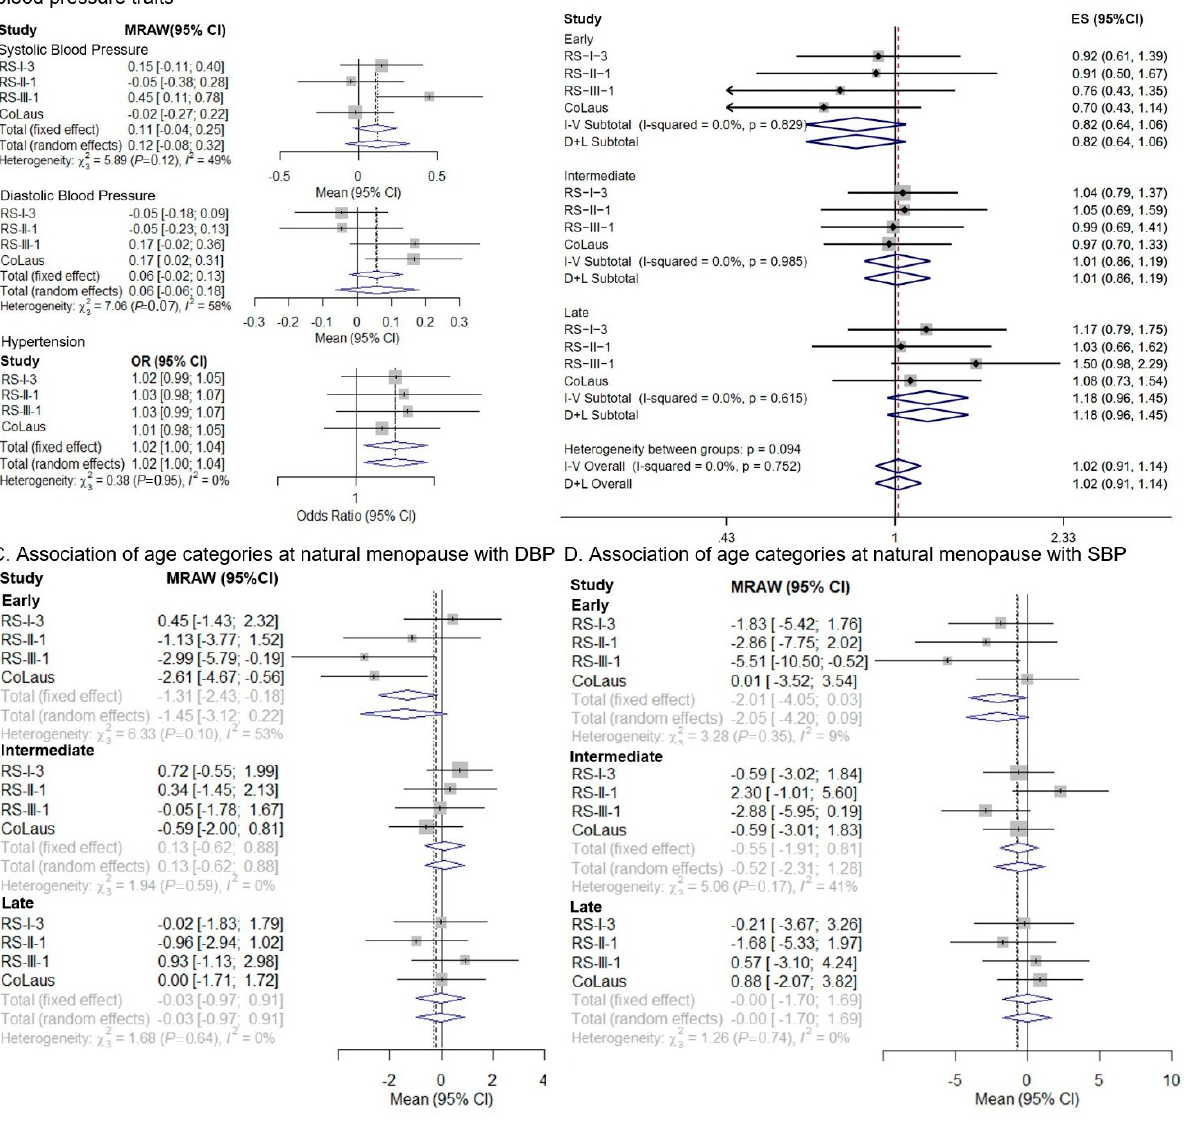
Figure 1. ( A ) Forest plot of observational estimates for the association between age at natural menopause (continuous) and blood pressure traits; ( B ) Forest plot of observational estimates for the association between categories of age at natural menopause and hypertension; ( C ) Forest plot of observational estimates for the association between categories of age at natural menopause and diastolic blood pressure (DBP); ( D ) Forest plot of observational estimates for the association between categories of age at natural menopause and systolic blood pressure (SBP). A fixed-effects meta-analysis model was used in all cases. Models adjusted for age and glomerular filtration rate, body mass index, total cholesterol, drinking status, education level, smoking status, diabetes, history of cardiovascular diseases, statin use, hormone therapy, and use of antihypertensive medication. Hypertension was defined as a systolic BP ≥ 140 mm Hg and/or diastolic BP ≥ 90 mm Hg, and/or the use of antihypertensive medication. Early 40–44, intermediate 45–49, normal 50–54, late ≥